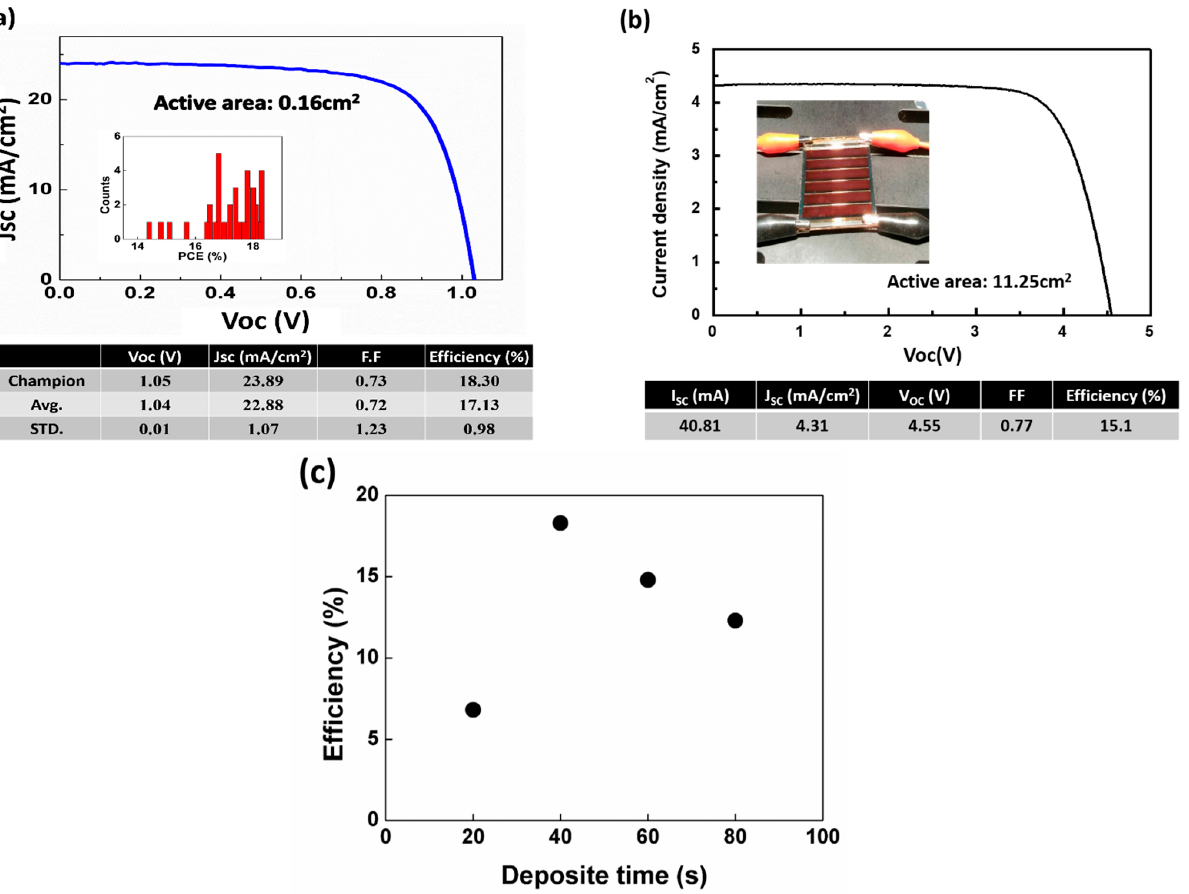
Figure 7. J sc -V oc curve and PCE related parameters of the perovskite device : ( a ) the statistic PCE from 36 devices are given as an inset (red bar chart). The average efficiency is 17.13%. A table shows averaged values and standard error of V oc , J sc , FF, and efficiency of 36 devices under AM 1.5G illumination (active area 0.16 cm 2 ).; ( b ) the perovskite device photograph for the module (25 cm 2 ) with an efficiency of about 15.1% (active area 11.25 cm 2 ). ( c ) shows the PCE efficiency of perovskite composed of NiO x thin films that annealed at 500 °C for 1 h with deposit times: 20 s, 40 s, 60 s, and 80 s, respectively.